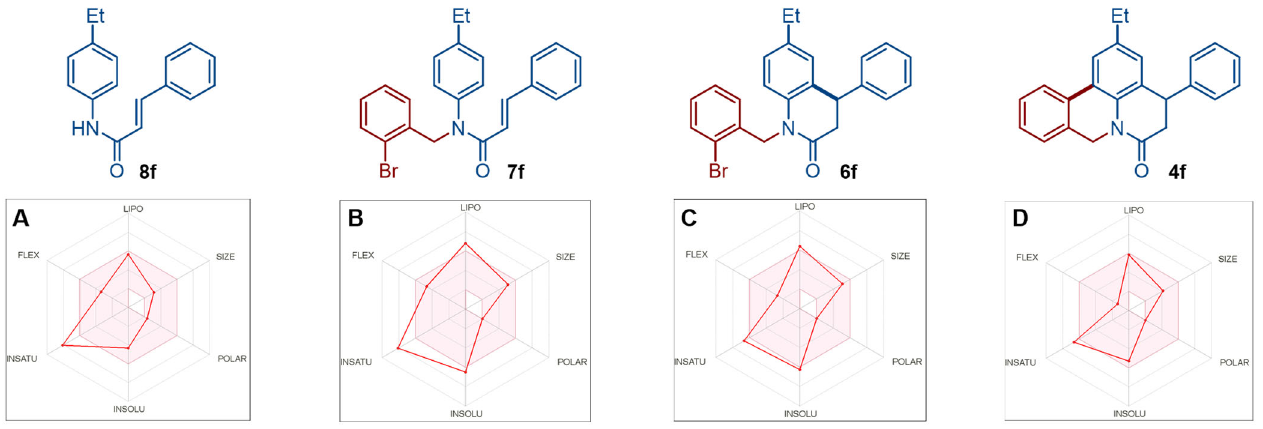
Figure 3. Bioavailability radars and physicochemical properties ( A – D ) for pyridophenanthridin ‐ 6 ‐ one 4f and its corresponding precursors 6f – 8f